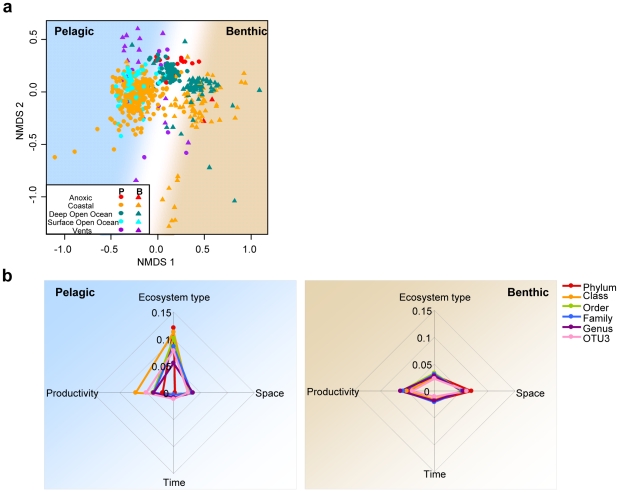
Consistency of patterns of community variation at various taxonomic levels.(a) NMDS ordination of the dissimilarity in bacterial community composition at the Phylum level (NMDS stress  = 0.15). The goodness-of-fit between this ordination and the ordination presented in Fig. 3a is shown in Table S4. Pelagic and benthic origins are indicated by the letters P and B, respectively. (b) Partitioning of the variation of bacterial composition at different taxonomic levels using the same approach as presented in Fig. 4. Units are expressed in adjusted R2 values, i.e. in proportion of explained variance.